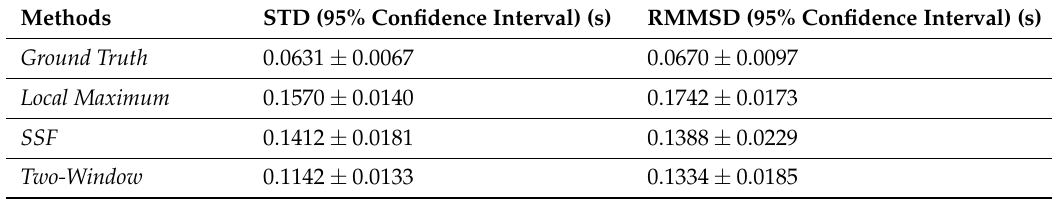
Table 5. The 95% Confidence Interval of the PRV features’ values.